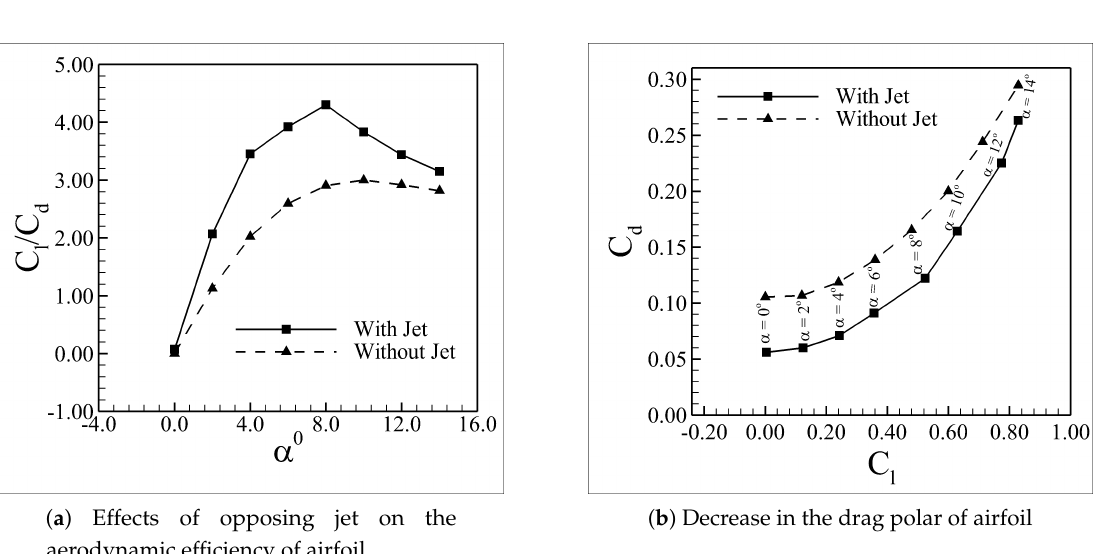
Figure 13. Effects of opposing jet by increasing the α .